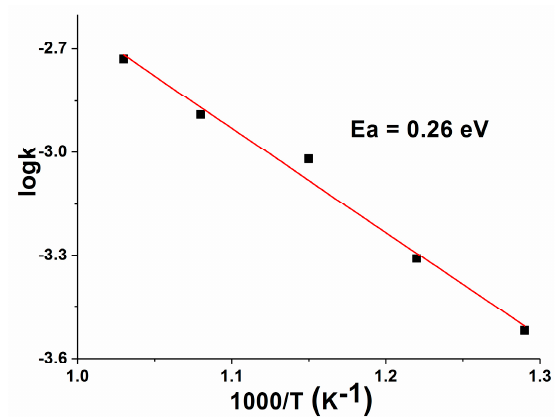
Figure 12. The dependence log κ = f(1/T) of the GP_CeO 2 _MGNP sample.